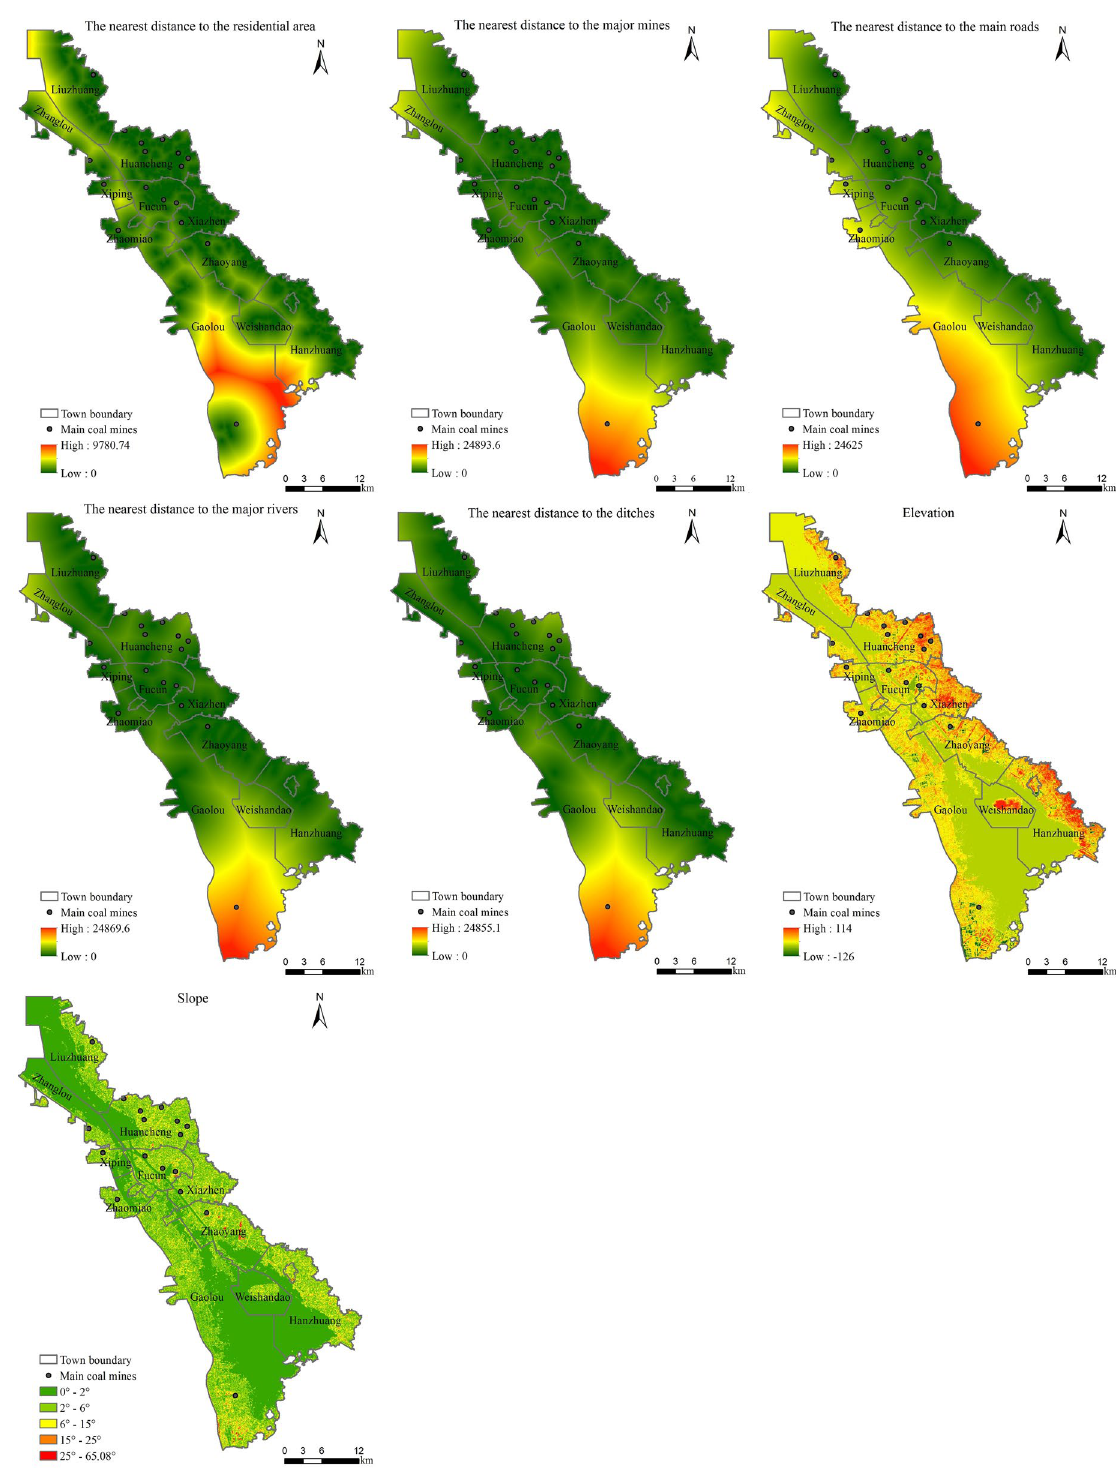
Figure 3. Raster maps of driving factors at a resolution scale of 60 m. Maps were generated using ArcGIS 10.1 for Desktop (http:// www. esri. com/ softw are/ arcgis/ arcgis- for- deskt